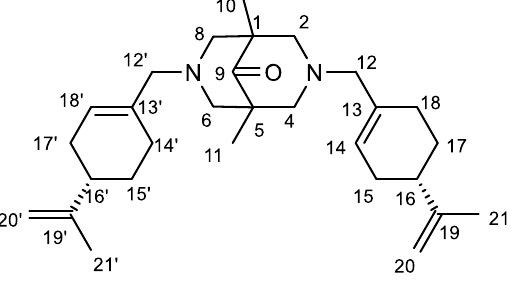
Figure 5. The structure of compound 42 with atom numbering scheme. A mixture of 476 mg (1.97 mmol) of bispidinonehydrochloride 16 , 2.5 eq of bromide 28 and 6 eq of K 2 CO 3 in 4 mL acetonitrile was heated in a microwave reactor to 75 °C and allowed to stand for 90 min. After cooling of the reaction mixture, the precipitate was separated, washed with ethyl acetate. The organic phases were combined, the solvent was evaporated. The product yield after chromatography was 610 mg (71%). 1 H NMR (600 MHz, CDCl δ , ppm, J , Hz; for the numbering of the atoms, see 3 , Figure 5): 0.96 s (6H, C10H3, C11H3); 1.39–1.47 m (2H, C 17 H a , C 17 (cid:48) H a − ); 1.72 br.s